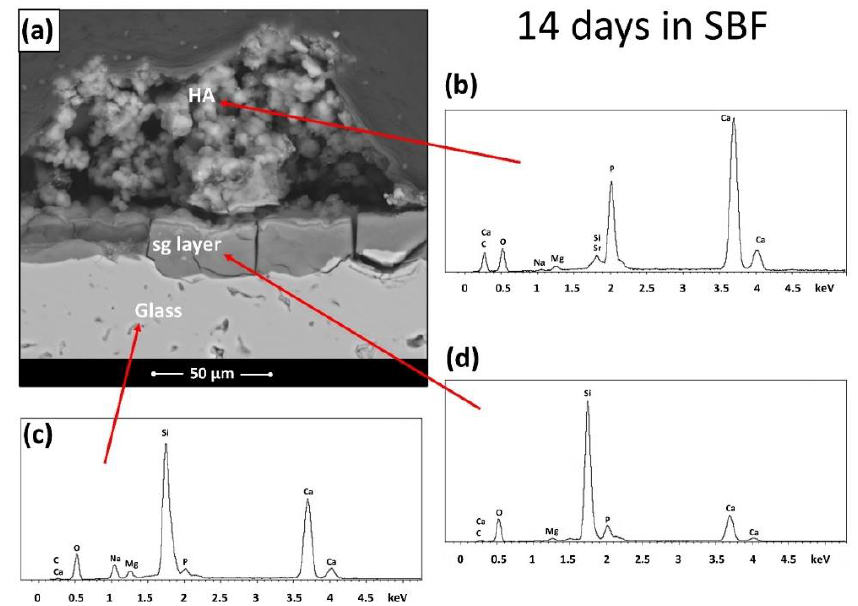
Figure 4. BGMS_LS samples after immersion in SBF for 14 days: ( a ) cross section and ( b – d ) EDS spectra.